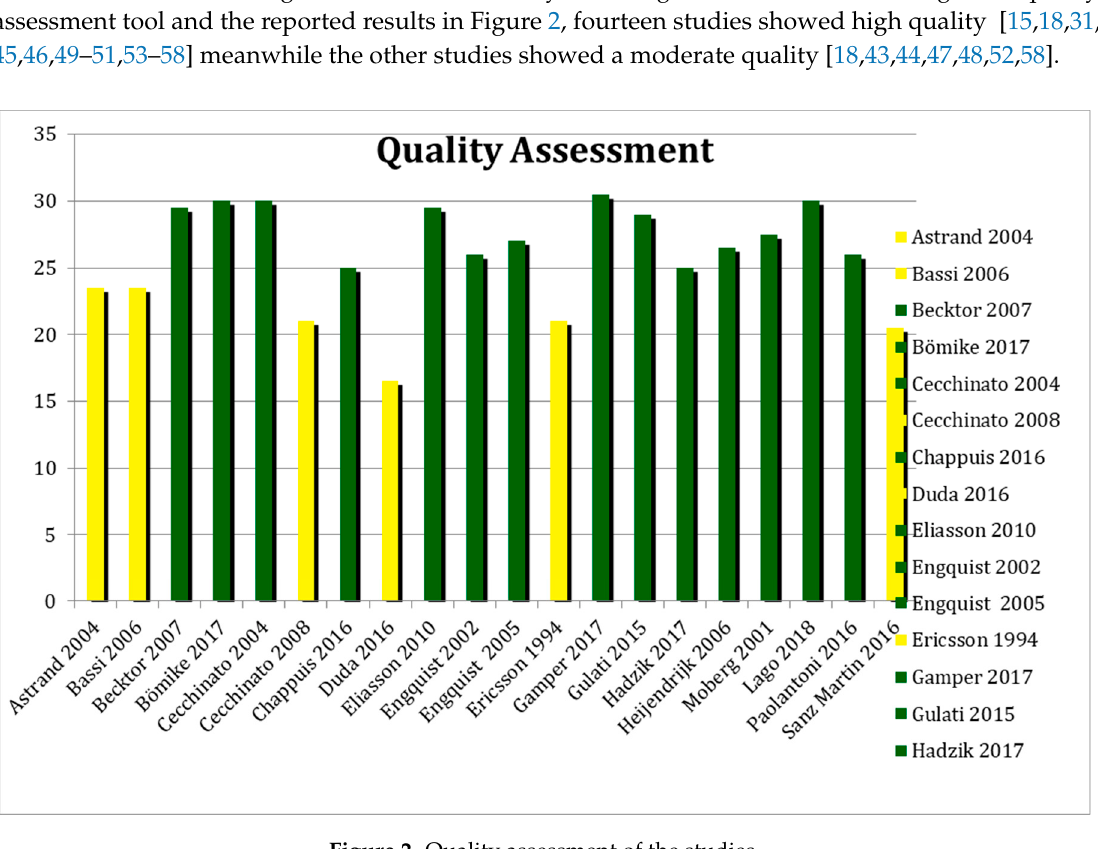
Figure 3. Risk bias word: Risk bias word: red–high risk; yellow–unclear; risk green-low risk. The tool items were scored as 1 if the item was considered fully fulfilled, as 0 if the item was clearly not fulfilled, and as 0.5 if the item was unclearly or only partially fulfilled. Studies with a score ≤ 2.3 were considered high risk of bias, with a score between 2.4 and 4.6 as moderate risk, and with a score ≥ 4.7 were considered low risk of bias. The majority of the studies showed a low risk of bias, whereas six studies had a moderate risk of bias: [43,44,48,50–52].